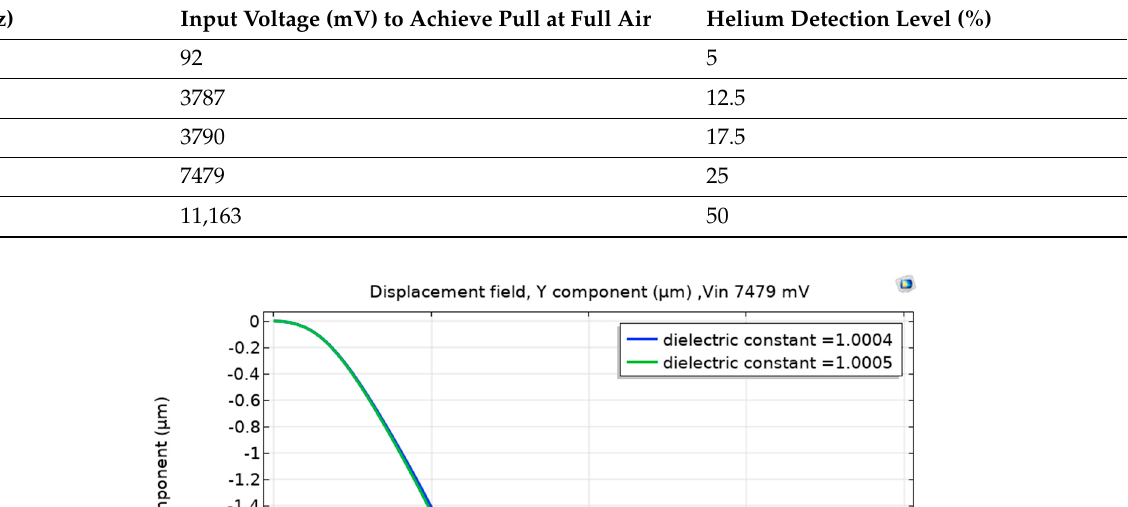
Figure 7. Helium detection at 3.78 MHz; it is noticeable that the detection level increased to 25%, degrading the sensor’s performance. Table 2. The e ff ect of excitation frequency on helium detection level and input voltage.